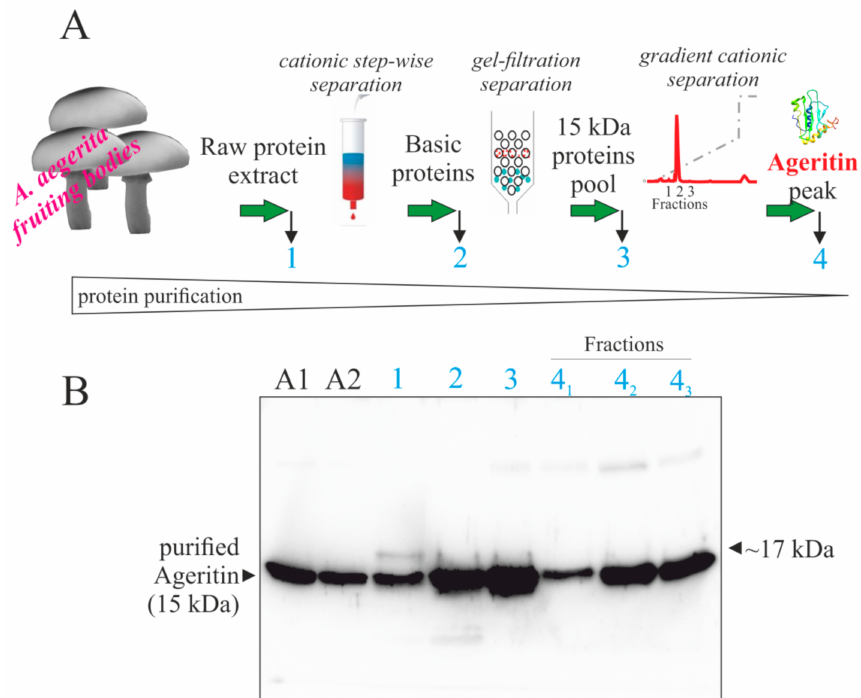
Figure 2. Western-blot analysis of soluble proteins from A. aegerita fruiting bodies during purification procedure (scheme A ). In ( B ): lane 1, 10 µ g of total protein extracted from total fruiting bodies; lanes 2, 3, and 4 (1, 2, 3 fractions) 2.5, 1.0, and 0.5 µ g of total soluble proteins after cationic